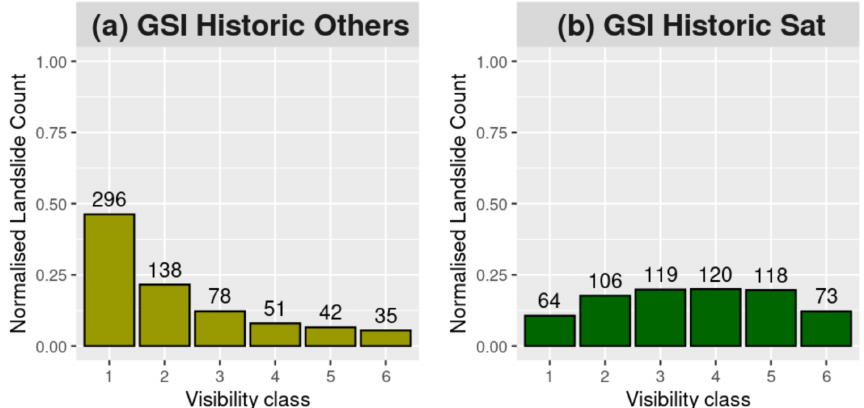
Figure 7. Normalised landslide count distribution plot for GSI Historic Others and GSI Historic Sat inventories. The values above each column signify the absolute number of landslides in each visibility